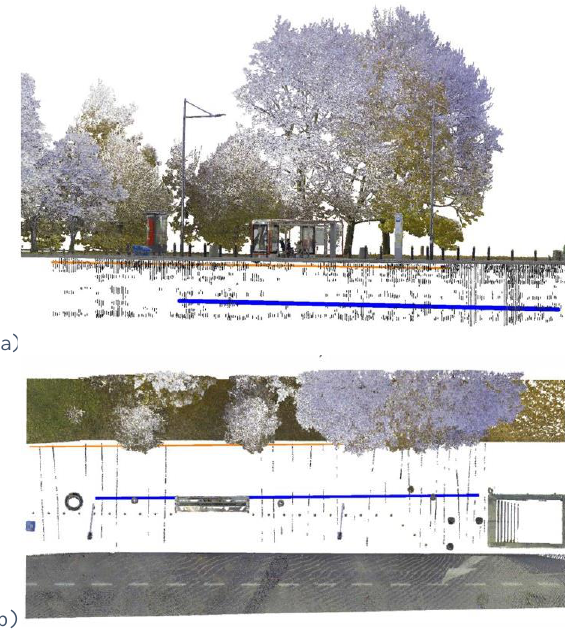
Figure 4. LiDAR and GPR data integration concept shows georeferenced point clouds collected with LiDAR and GPR antenna (a) indicating the water supply network showed in a top of view confirmed by manhole hatches location